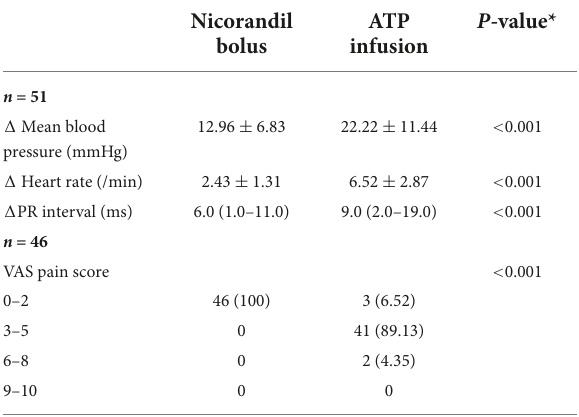
TABLE 2 Hemodynamic changes and visual analog scale (VSA) pain score according to hyperemic agents. Nicorandil bolus